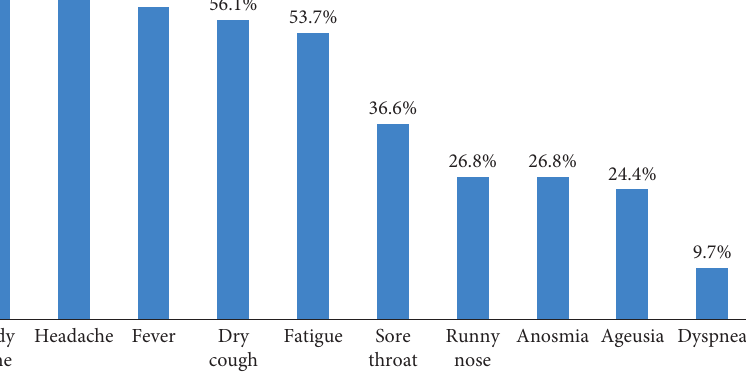
Figure 2: Clinical presentations among HCWs who tested positive for